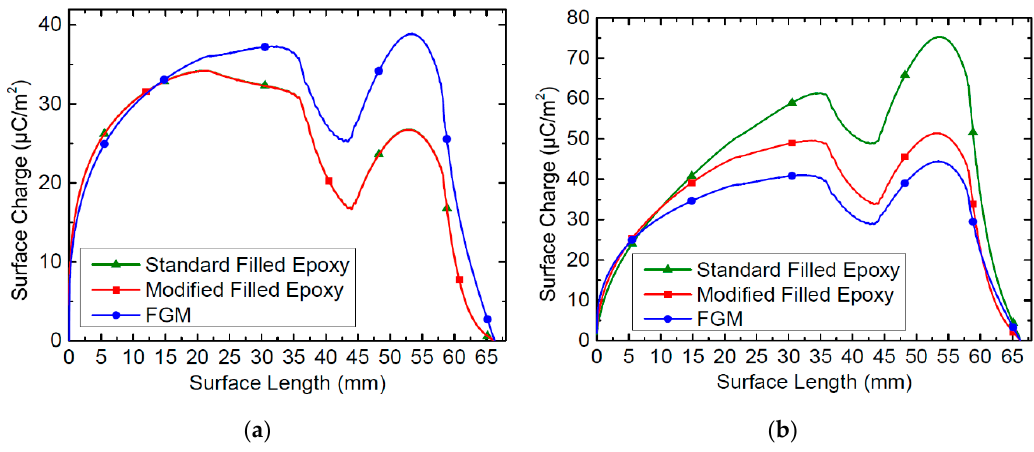
Figure 12. Accumulated charges at the spacer’s upper surface under 131.3 kV DC for ∆ T = 0 ◦ C ( a ) and ∆ T = 40 ◦ C ( b ) of the standard filled epoxy, modified filled epoxy and FGM. At uniform temperature, the maximum surface charge density is 34.2 µ C / m 2 for both the standard AC alumina-filled epoxy and modified filled epoxy, since they have the same weak electric field-dependent conductivity, and 38.9 µ C / m 2 for the FGM.